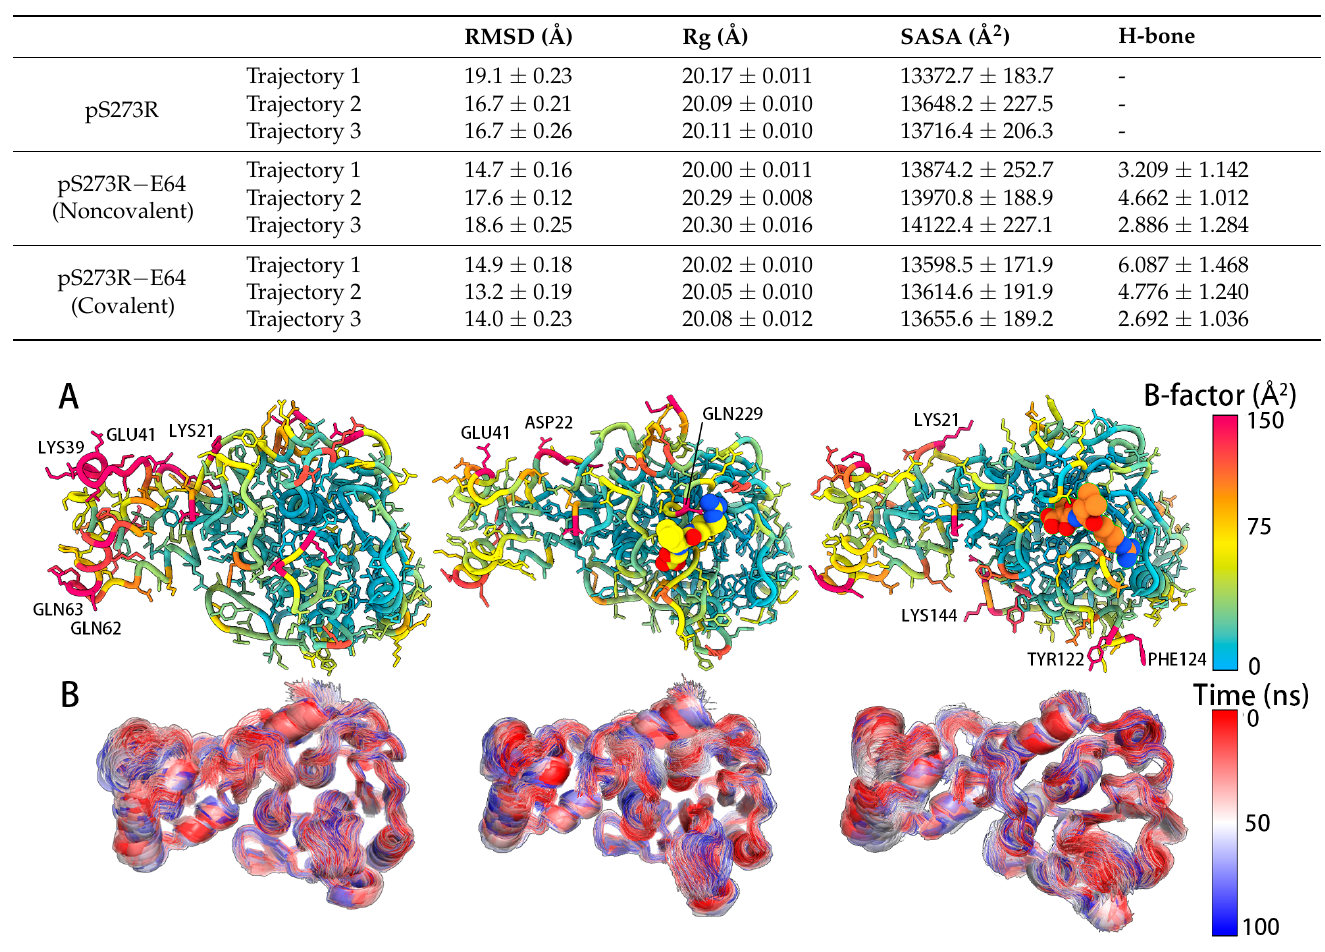
Table 4. Molecular dynamics simulations of RMSD, Rg, SASA, RMSF and intermolecular hydrogen bonds extracted from three sets of pS273R, pS273R and E64 (non-covalent/covalent) complexes at 100 ns duration.